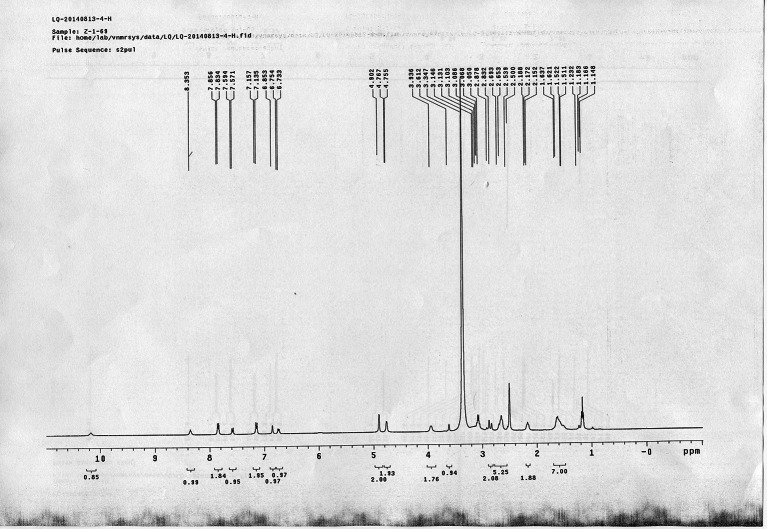
1H NMR spectra of AL.